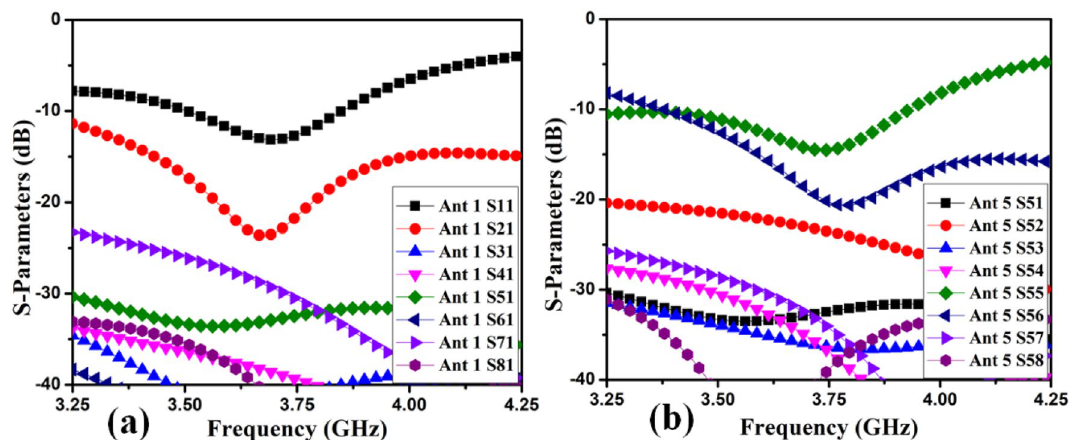
Figure 26. Proposed 8 Members mobile frame-based MIMO antenna S-Parameters simulated results ( a ) Ant 1, ( b ) Ant